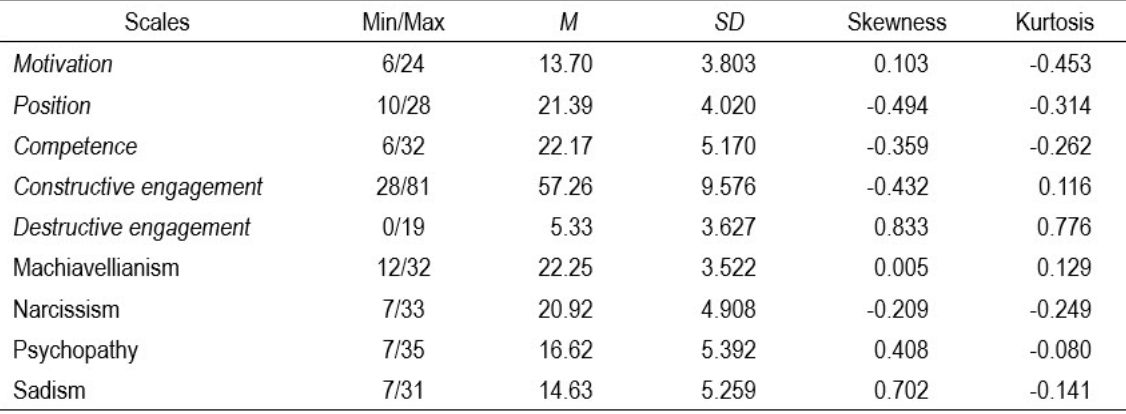
Descriptive statistics (N=424)